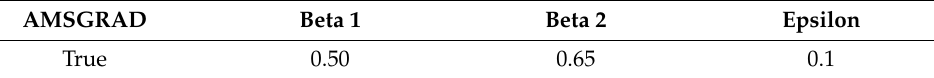
Figure 5. Learning curves of the training process and the learning rate-decreasing curve. Table 4. Configuration used for the adaptive moment estimation (Adam) optimizer in the training process.